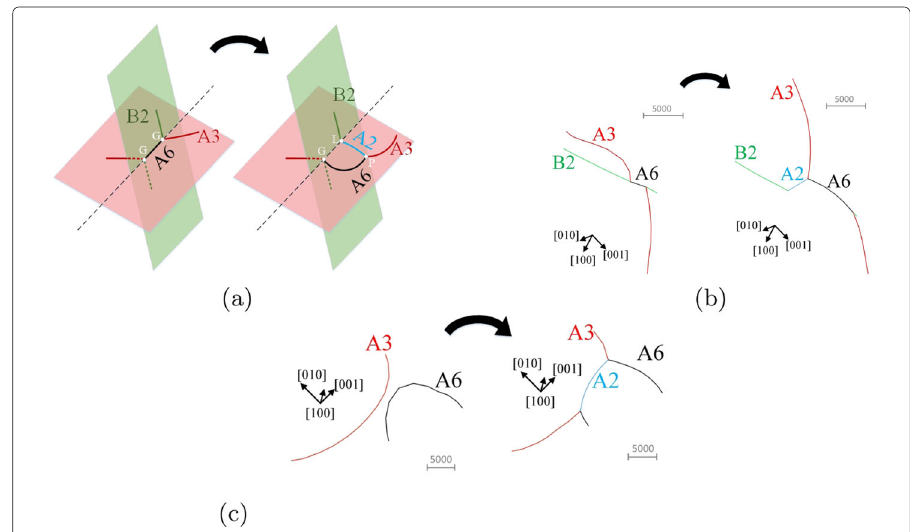
Fig. 9 a Schematic of an A2 segment formed by a glissile+coplanar mechanism, following the glissile junction formation shown in Fig. 6a, with i =A3, j =B2, k =A6. Both A3 and A6 are active and can bow out to form a new A2 link. G, P and L refer to the type of link end nodes (see text). b Two consecutive DDD snapshots showing the glissile+coplanar mechanism. Only dislocations on one plane of type A and dislocations on slip system B2 are shown. c Two consecutive DDD snapshots showing the coplanar (A3+A6=A2) mechanism. Only the dislocations on a single plane of type A are shown. In b and c , the scale bar is in units of b = 0.255nm, and the coloring scheme is consistent with a